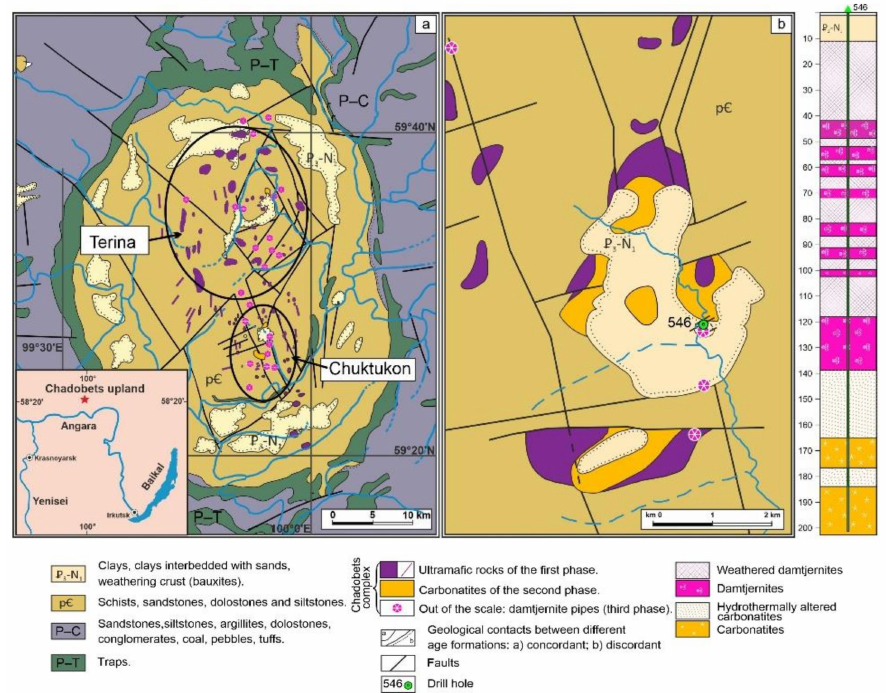
Figure 1. ( a ) Geological scheme of the Chadobets upland and ( b ) the Chuktukon massif within the upland and cross-section for the 546 drillhole ([36] and unpublished data from geological report of “Krasnoyarskgeols’emka”,